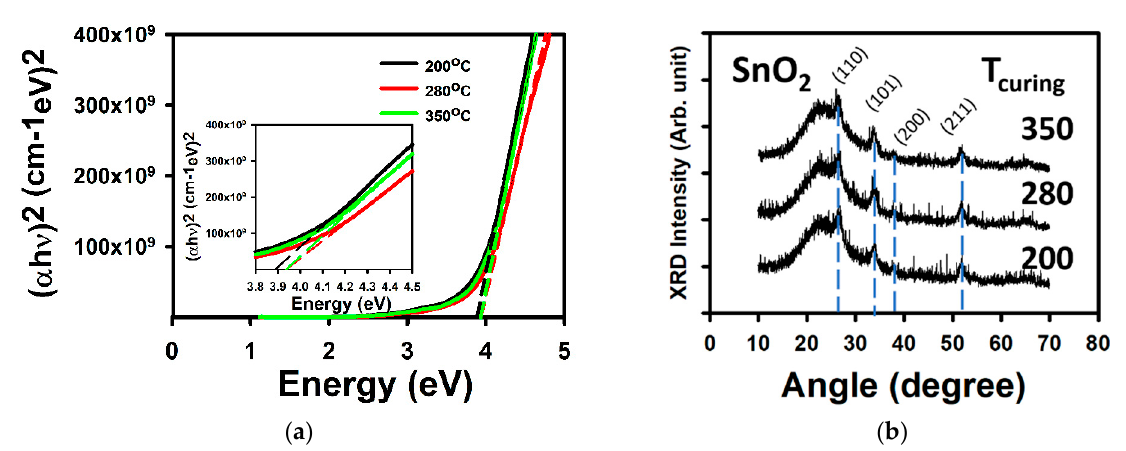
Figure 1. Thin film properties of solution processed SnO 2 cured at 200, 280, and 350 °C, and annealed at 350 °C. ( a ) The Tauc plot for the extraction of the optical bandgap. The inset shows the energy between 3.8 and 4.5 eV. ( b ) XRD patterns. The dashed lines with the respective colors show the extraction of the bandgap. The dashed blue lines in ( b ) are here to help identify the various positions of the main peaks.